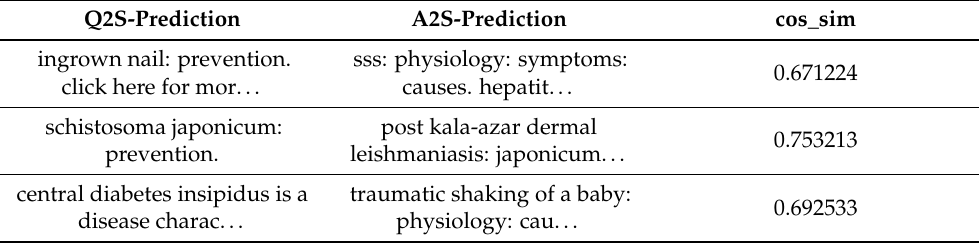
Table 10. Prediction results of our system: full negatives.